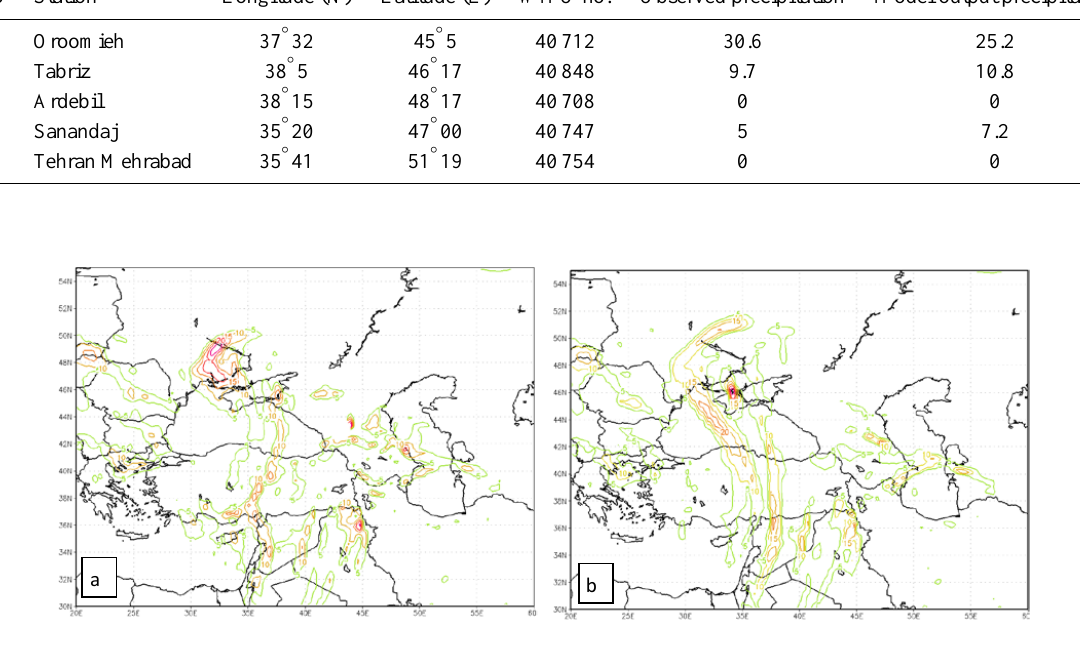
) for 14 March 2009 at 0000 UTC − 1 5 𝑆𝑆 × 10